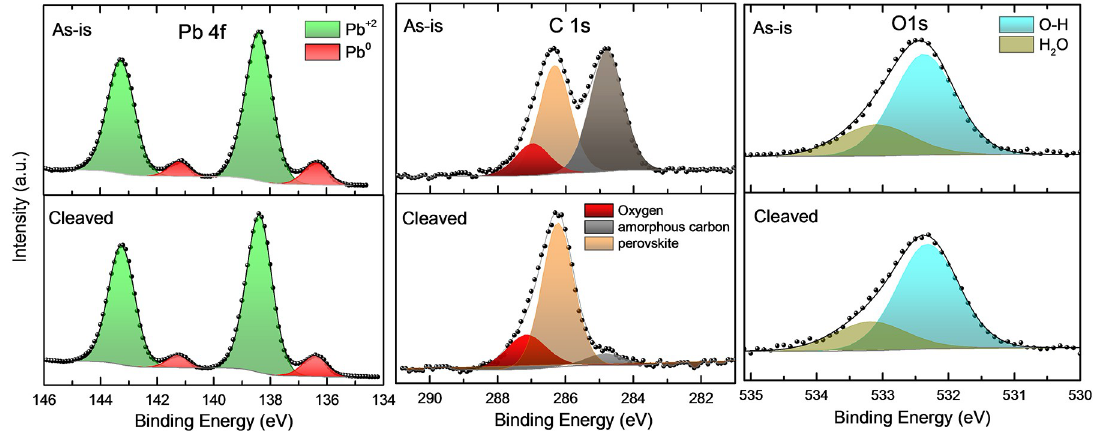
Fig 1. Presence of Pb˚ and chemical contaminants. XPS data showing the Pb 4f, C 1s and O 1s core level peaks for the as-is and cleaved surfaces of crystals. Pb 4f peaks show a shoulder (red) ca . 2 eV below the main peaks (green), corresponding to Pb˚. C 1s core peaks can be split into three components: amorphous carbon (grey), carbon belonging to methylammonium (orange), carbon belonging to oxygen- functionalities (red). Oxygen functionalities, depicted by O 1s comprise of O-H (blue) and adsorbed water (green) components. Possibly, the O-C species overlaps the O-H